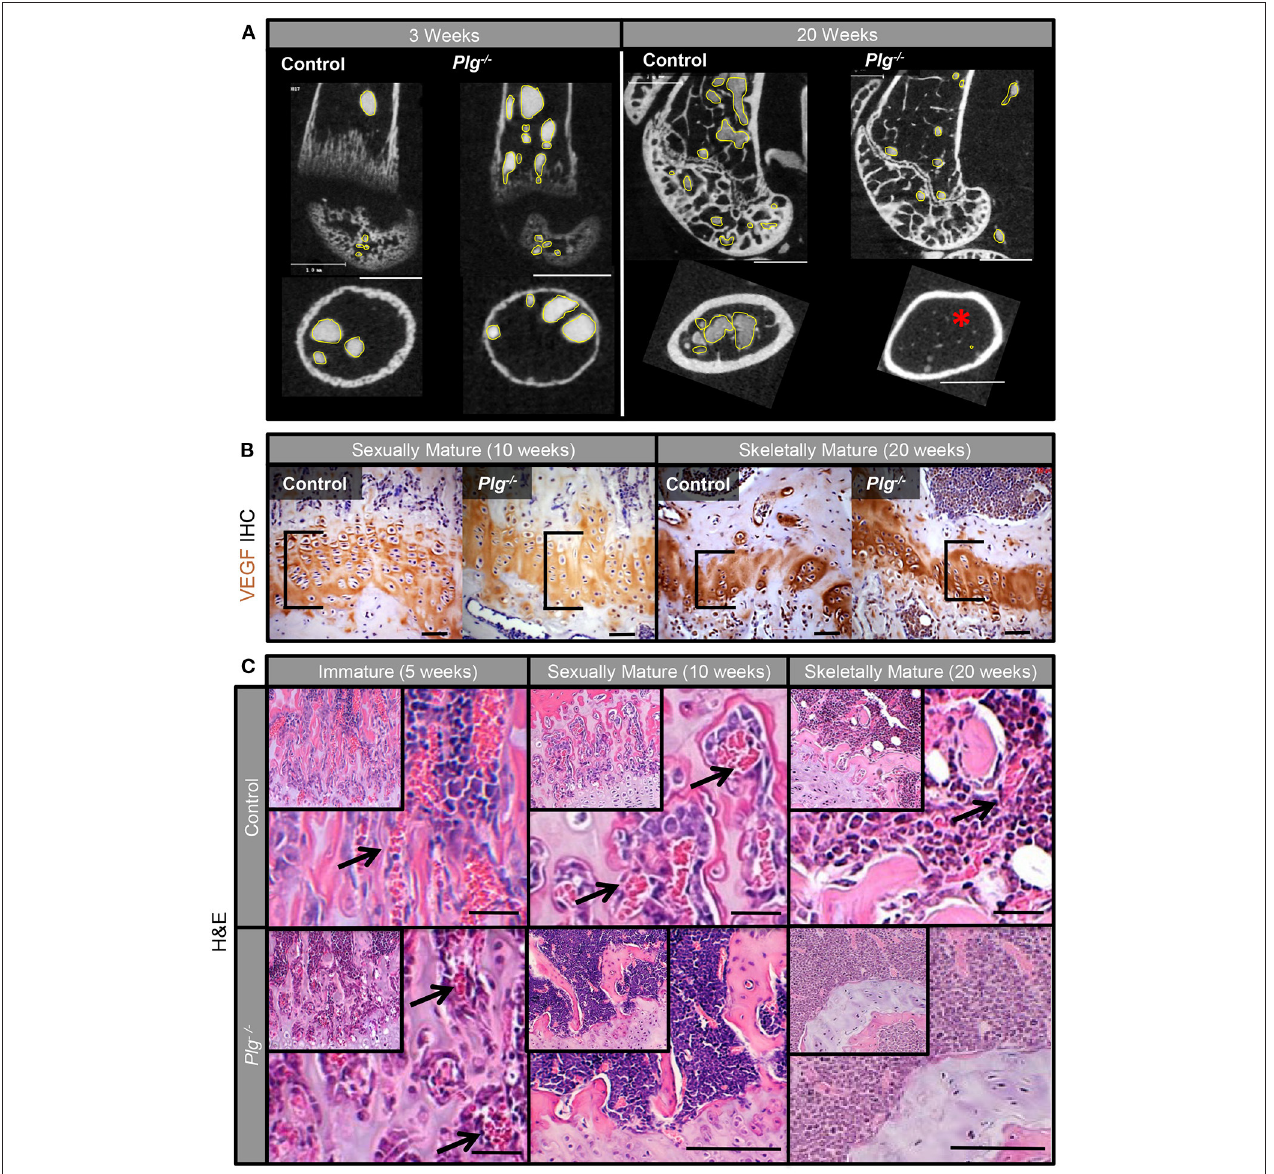
FIGURE 3 | Impaired fibrinolysis, as a result of a plasminogen deficiency, leads to the loss of acquired physeal vasculature. (A) Angiography of the distal femur of Plg − / − and WT control mice at 3 weeks of age demonstrated that Plg − / − mice develop a normal epimetaphyseal vascular supply. After skeletal maturity (20 weeks of age), there is markedly reduced epimetaphyseal and epiphyseal vasculature in Plg − / − mice compared to WT controls [2D µ CT images; vascular spaces outlined in yellow; red asterisk denotes lack of metaphyseal vessels (white scale bars, 1mm)]. (B) Immunohistochemical staining for vascular endothelial growth factor (VEGF) shows no discernable differences in VEGF immunoreactivity within the physis (black brackets) of WT control and Plg − / − mice at 10 and 20 weeks of age [magnification 40 × (black scale bars, 20 µ m)]. (C) H&E stains of the physis in Plg − / − and WT control mice at 5, 10, and 20 weeks of age. Whereas, the physeal vasculature (black arrows) is comparable in Plg − / − and WT mice at 5 weeks of age (immature phase), the physeal vasculature within the zone of provisional ossification is markedly reduced in Plg − / − mice at 10 and 20 weeks of age [H&E, magnification 20 × inset; 40 × main image (black scale bars, 100 µ m)].